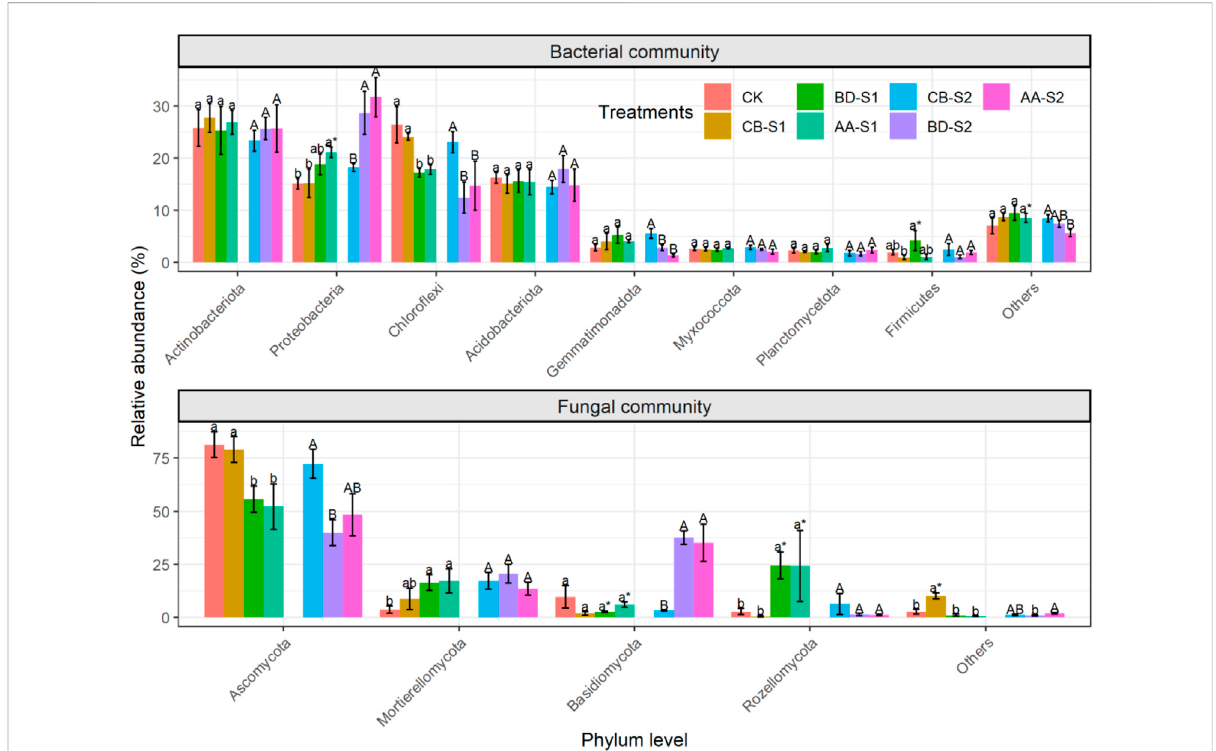
FIGURE 1 Soil microbial composition at the phylum level for bare soils and rhizosphere soils of three metal-tolerant plants at S1 and S2. CB, BD and AA respectively represented C. breviculmis , B. davidii , and A. annua . S1, sample site on the zinc smelter waste heap; S2, sample site around the zinc smelter waste heap. Mean values (mean ± se, n = 4) followed by different lowercase letters presented signi fi cant differences of sampled soils collected on the zinc smelter waste heap (S1), by different capital letters represent signi fi cant differences of sampled soils collected near